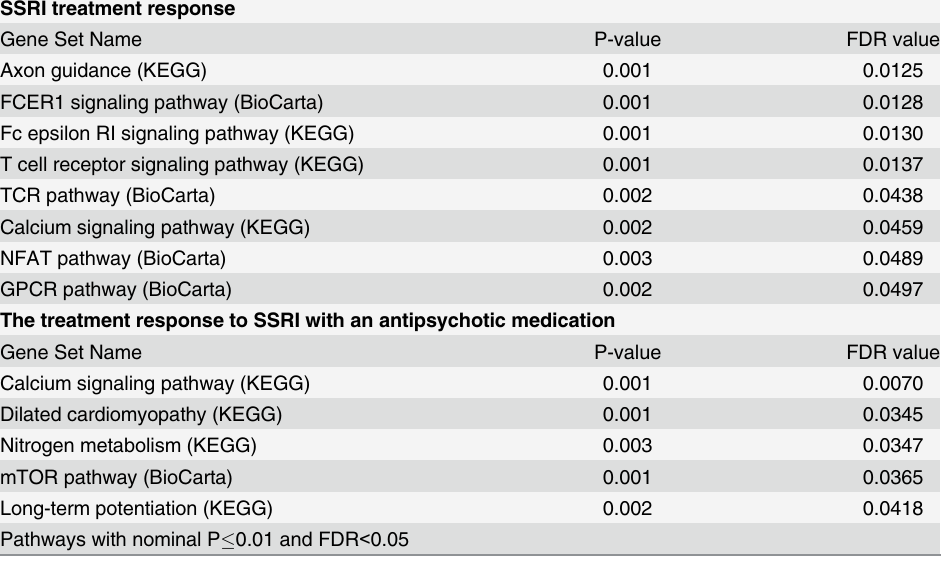
Table 3. Pathway-based analysis for the results of GWAS for the treatment response in